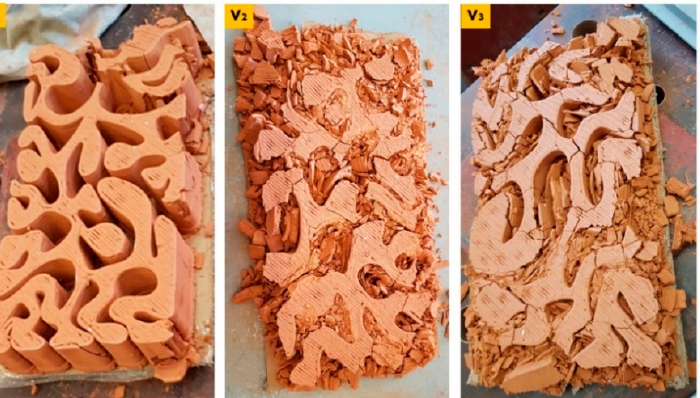
Figure 16. Exhibits comparison between the cumulus of three bulk brick models, V1, V2, and V3, post-collapsing as a result of the compression test. It can be observed that the V1 exhibited the highest resistance since it did not collapse and maintained its coherency all over its body with minimum damage at the peripheries. Followed by V3 despite collapsing at the lowest force value at 135 N. While the V2 bulk brick model was the most affected.